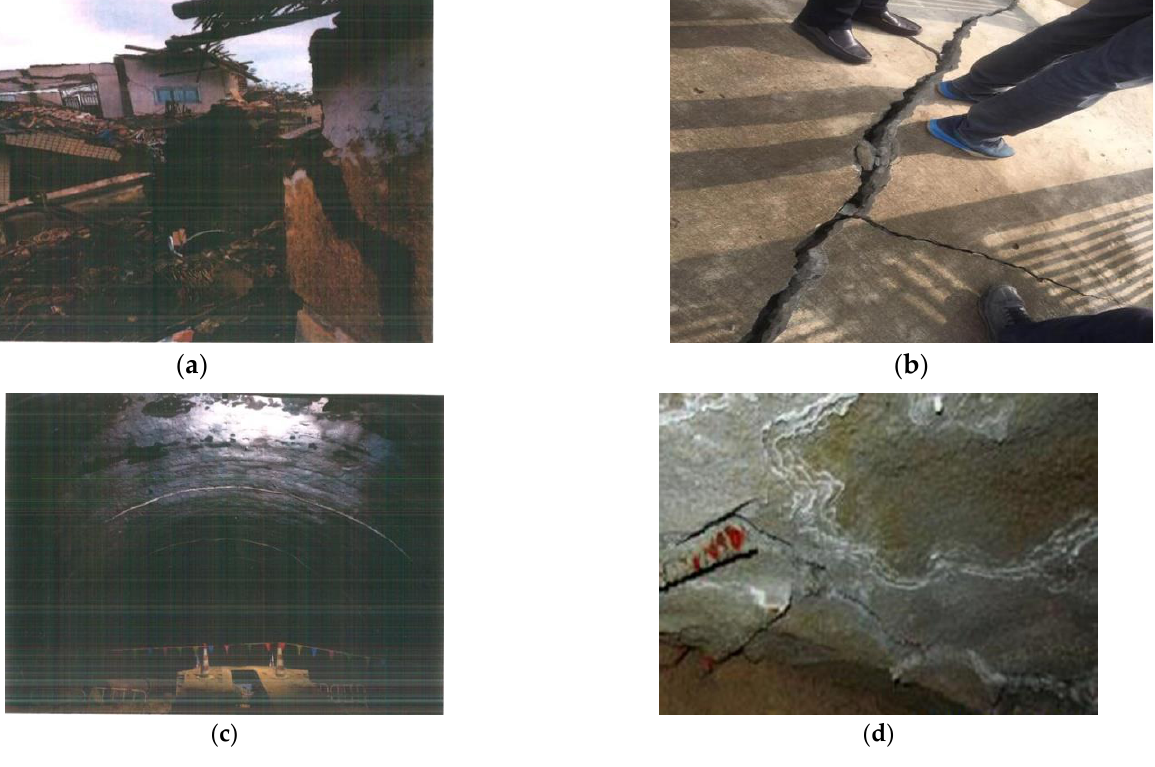
Figure 3. Tunnel collapse scenario: ( a ) surface house collapse; ( b ) slab staggering fissure; ( c ) collapse and roof fall in the tunnel; ( d ) concrete cracking and peeling.